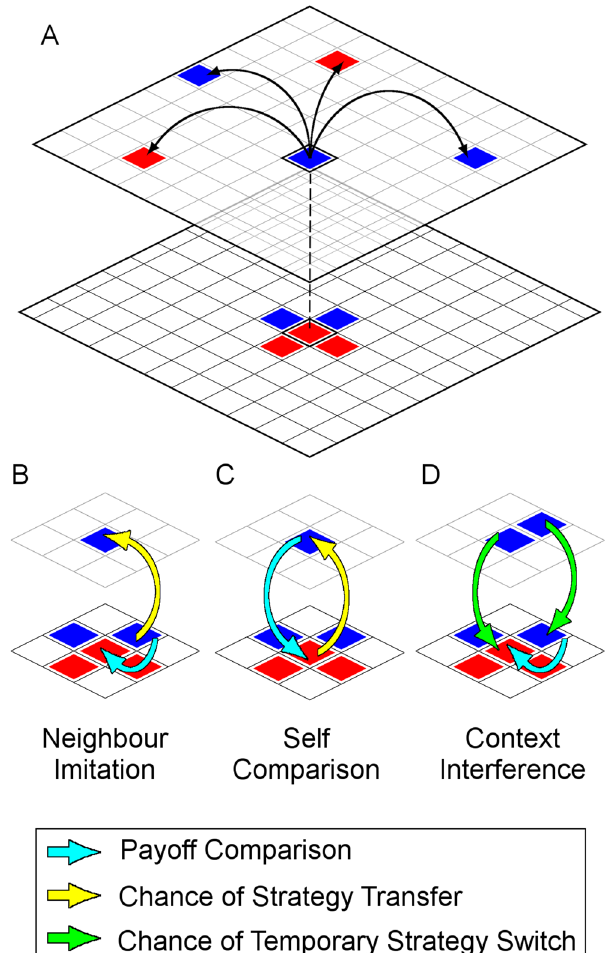
Figure 1. Spillover modes in multiplex games. In ( A ) On the bottom layer, individuals play the iterated prisoner’s dilemma on a square lattice with periodic boundary. On the top layer, they play the one shot prisoner’s dilemma on a random regular network with degree four. Individuals compare payoffs with neighbours within the layer, to decide whether to adopt a neighbour’s strategy in that layer. In addition, there is a probability of using one of the three spillover modes instead, to adopt strategies from another layer. For ( B ) neighbour imitation mode, the individual compares payoff with neighbours on the same layer, and applies adopted strategies to the opposite layer. In ( C ) self comparison mode, the individual compares her normalized payoffs on each layer, and decides whether to implement her strategy from one layer in another. For ( D ) context interference mode, the individual is susceptible to temporary interference from mistaking the context of the interaction, which results in temporarily using strategies from the opposite